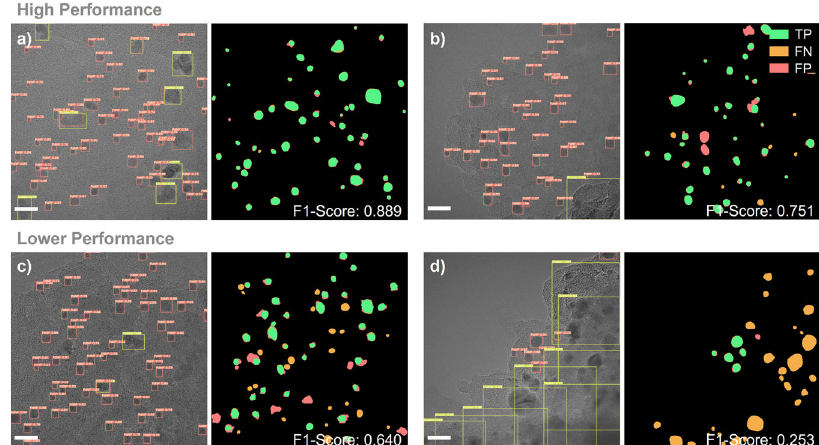
Fig. 3 Object detection with colour-coded segmentation masks for the Pd/C system. a , b Cases of high performance. c , d Cases with lower performance. The colour legend for this fi gure is shown only in ( b ). ‘ Nanoparticle ’ instances are labelled in orange as ‘ PdNP ’ while ‘ cluster ’ instances are labelled in yellow as ‘ Cluster ’ in the object detection outputs respectively. Scale bar: 20